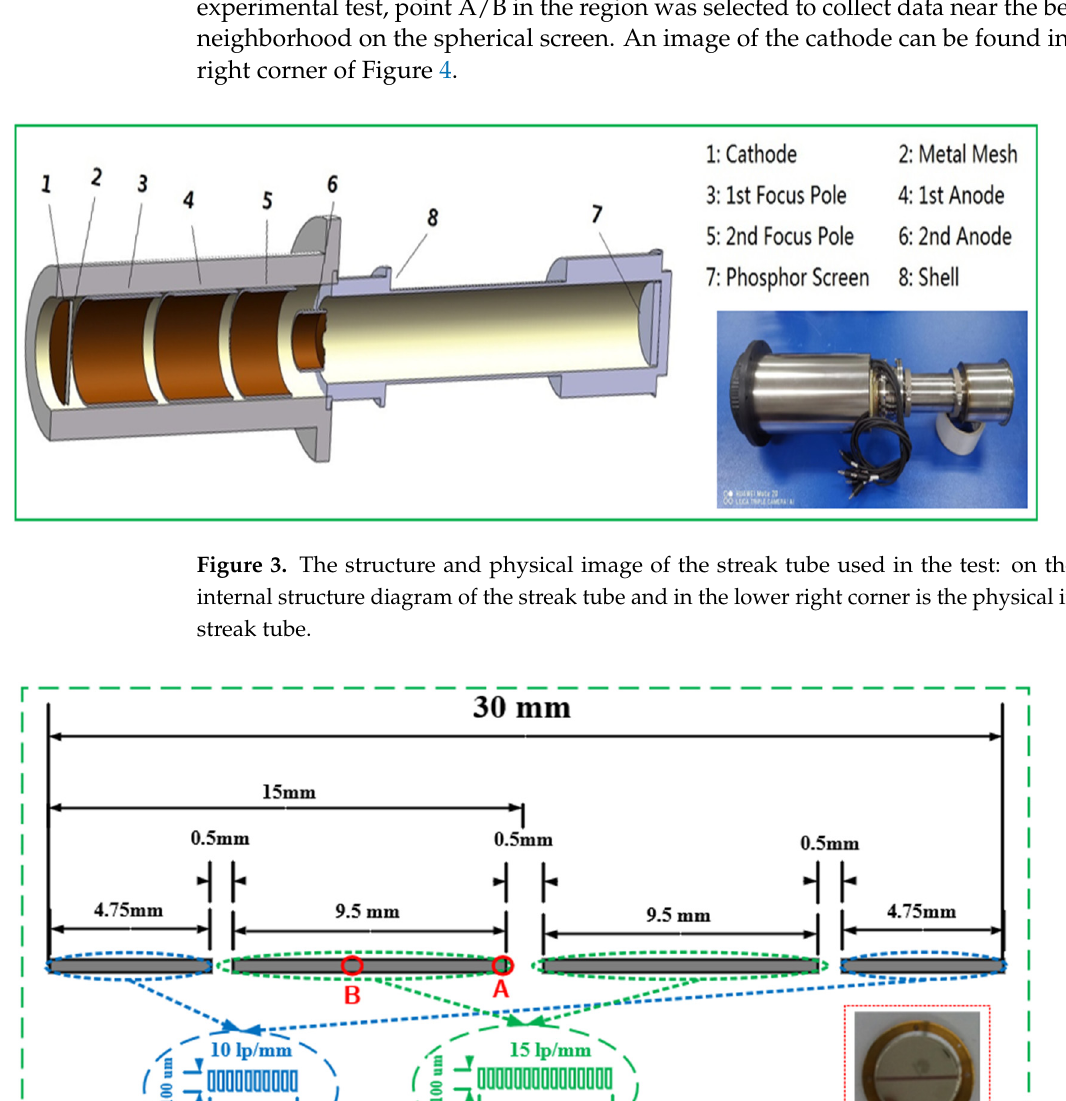
Figure 4. A schematic diagram of the reticle pattern: The spatial resolution of the two parts with the center length of 9.5 mm is 15 lp/mm, as marked by the green text in the figure. The two sides are 10 lp/mm, as shown in the blue text and accompanying schematic diagram in the figure. In the lower right corner is the physical image of the prepared